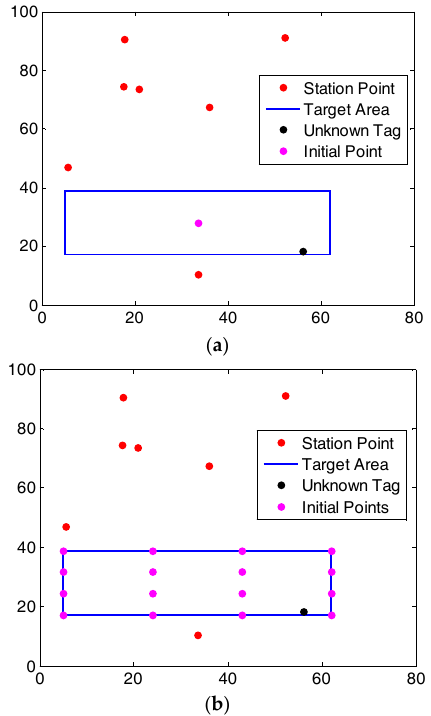
Figure 6. Layout of the station and initial search points (in m): ( a ) single initial guess, ( b ) 16 initial guesses.